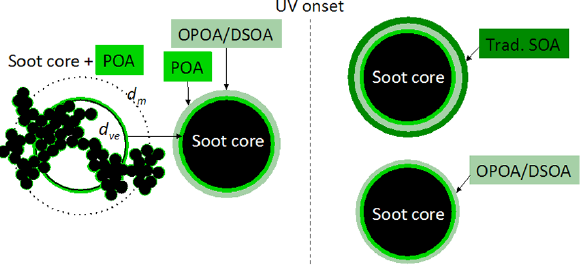
Figure 8. A conceptual model illustrating different processes which might affect the activation properties of the soot particles in the early stage of ageing. Here, POA is evenly distributed over the ag- glomerate. The volume-equivalent diameter is used to account for the non-sphericity of the particles. In dark conditions (before the onset of UV radiation) POA on the soot surface might be oxidised, i.e. oxidised primary organic aerosol (OPOA). Another possibil- ity is that gas-to-particle conversion processes may occur, i.e. sec- ondary organic aerosol produced in dark conditions (DSOA) con- denses onto the soot particles. At the onset of UV the organic mate- rial on the soot surface (OPOA and/or DSOA) might be further ox- idised, and/or condensation of oxidised material (traditional SOA), and/or condensation of small amounts of organonitrates transforms the particles from non-activating into activating CCN, at ∼ 2% su- persaturation.